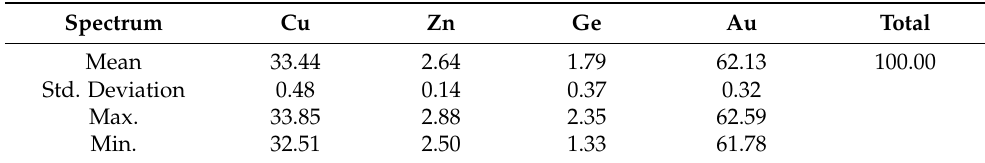
Table 1. Results of the micro-chemical EDS analysis: surface AuCuZnGe before corrosion testing (in wt.%).